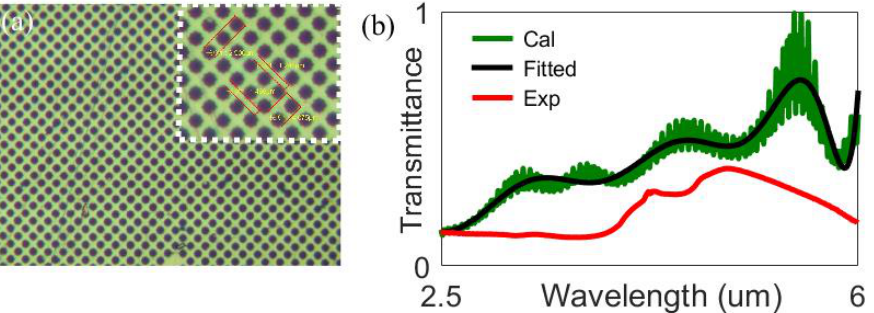
Figure 7. ( a ) SEM image with the periodically arranged micro/nano structure and the partial enlarged view. ( b ) The transmission spectrogram. Among them, the green curve is the case of cascade computing; the black curve is the result of 10th degree polynomial fitting for the cascade calculation; and the red curve is the actual measurement result.